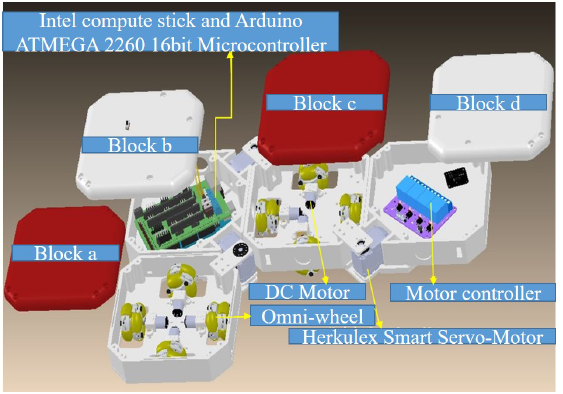
Figure 2. hTetro platform with hardware component setting.